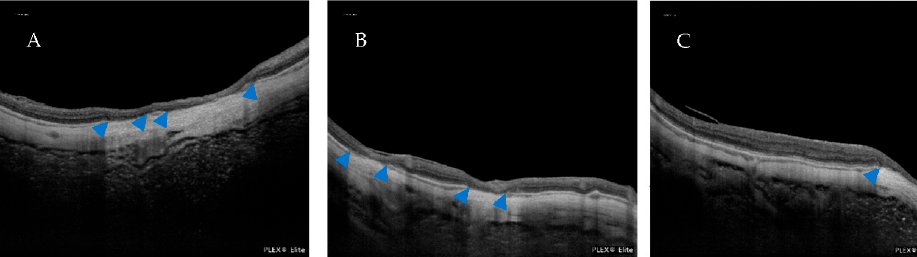
Figure 7. ( A ) An OCT scan of the BMDs associated with patchy atrophy. ( B ) An OCT scan of a BMD involving the fovea. ( C ) An OCT scan of a BMD associated with peripapillary atrophy. Blue arrowheads indicate the presence of BMDs. A total of 45 eyes (24%) had extrafoveal retinoschisis, of which 20 (46.5%) had inner and outer retinoschisis, 11 (25.64%) had inner retinoschisis only, and 6 had purely outer retinoschisis. Two eyes had either inner or outer retinoschisis and a lamellar hole and two eyes had both inner and outer retinoschisis and a lamellar hole (Figure 8).